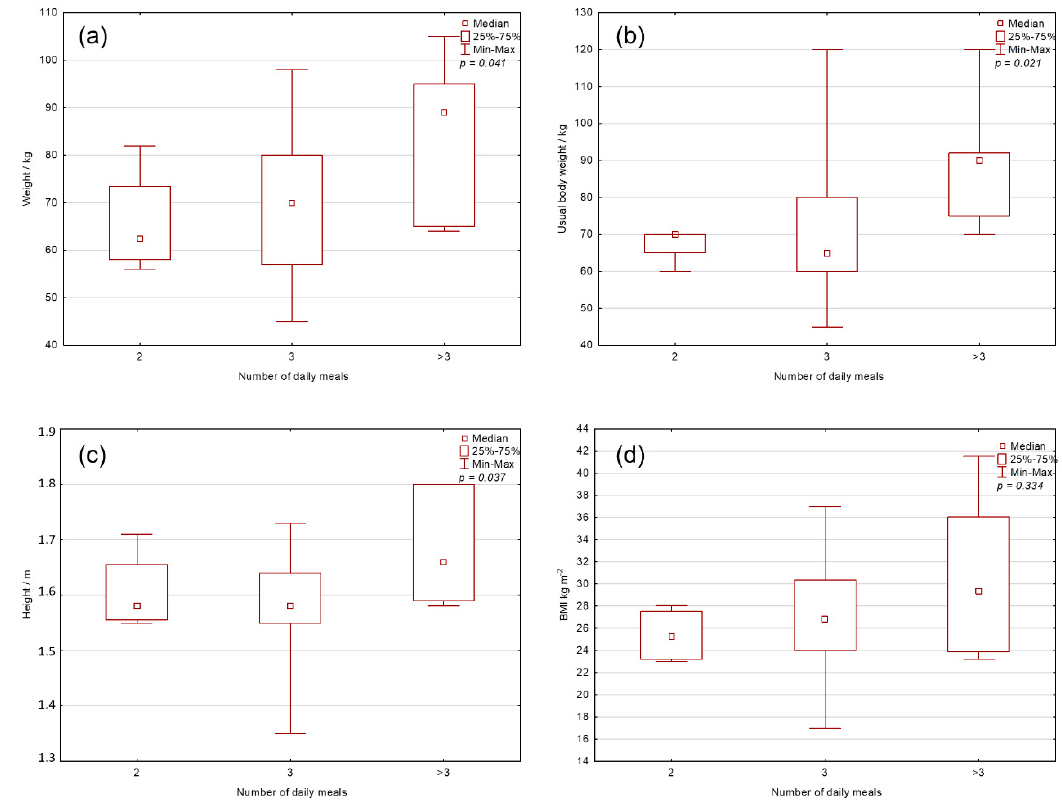
Figure 3. Comparison of the number of daily meals and: ( a ) body mass; ( b ) common body mass; ( c ) height; and ( d ) body mass index. The groups were compared by Mann–Whitney U test ( p values are on graphs).